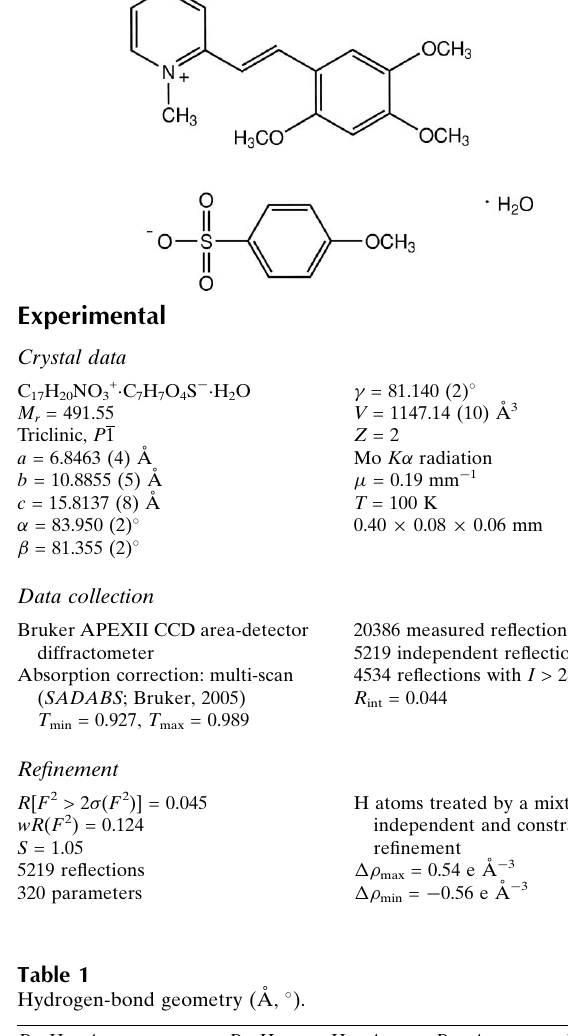
Hydrogen-bond geometry (A˚ , (cid:4) ). D —H (cid:2)(cid:2)(cid:2)